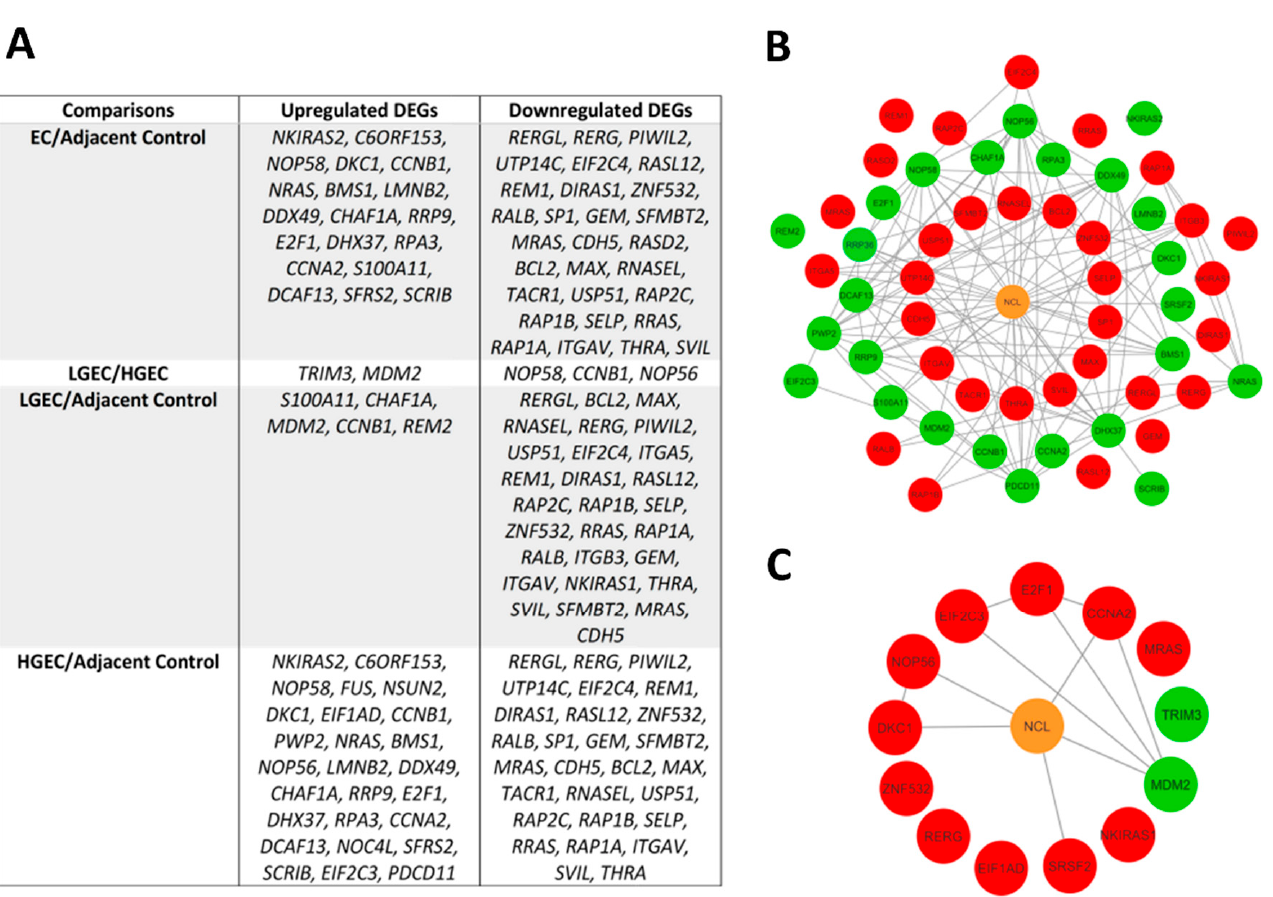
Figure 6. ( A ) Table of DEGs commonly upregulated and downregulated between those exposed and not exposed to hormonal, radiation, or neoadjuvant therapy. ( B ) Protein–protein interaction network displaying upregulated and downregulated DEGs in those exposed and not exposed to hormonal, radiation, or neoadjuvant therapy. Green and red nodes represent upregulated and downregulated DEGs, respectively. ( C ) Protein–protein interaction network of favourable (green) and unfavourable (red) genes in endometrial cancer.